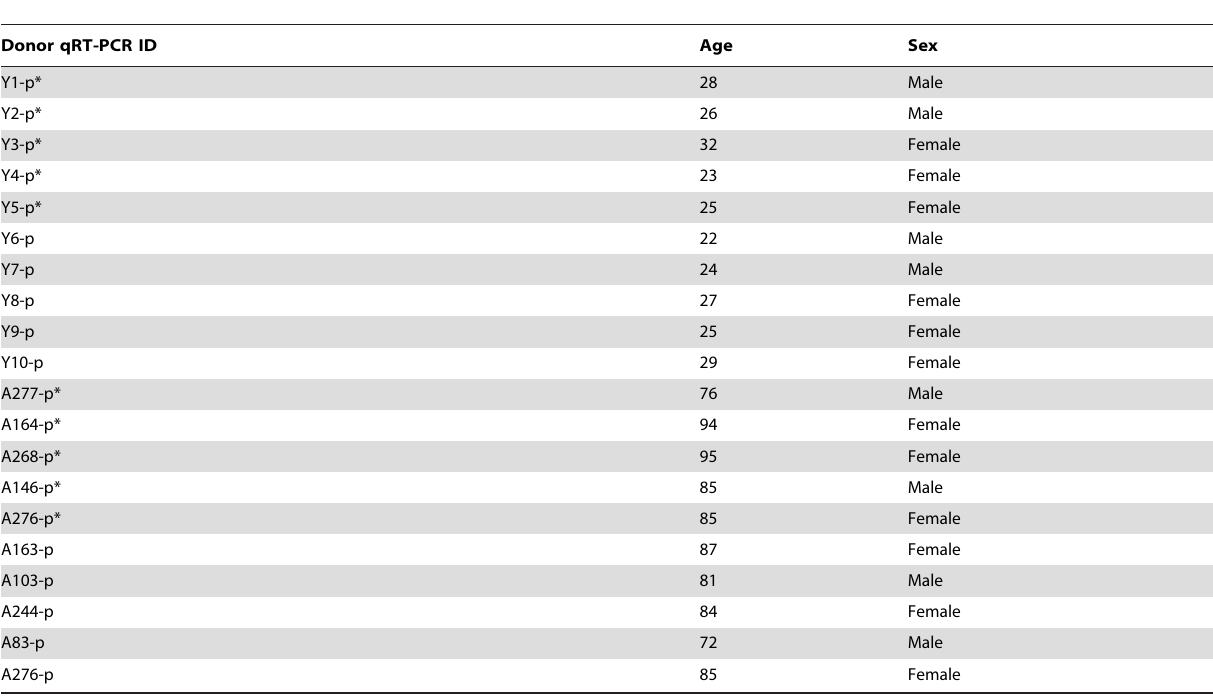
Table 2. MoDCs donor characteristics for qRT-PCR and cell